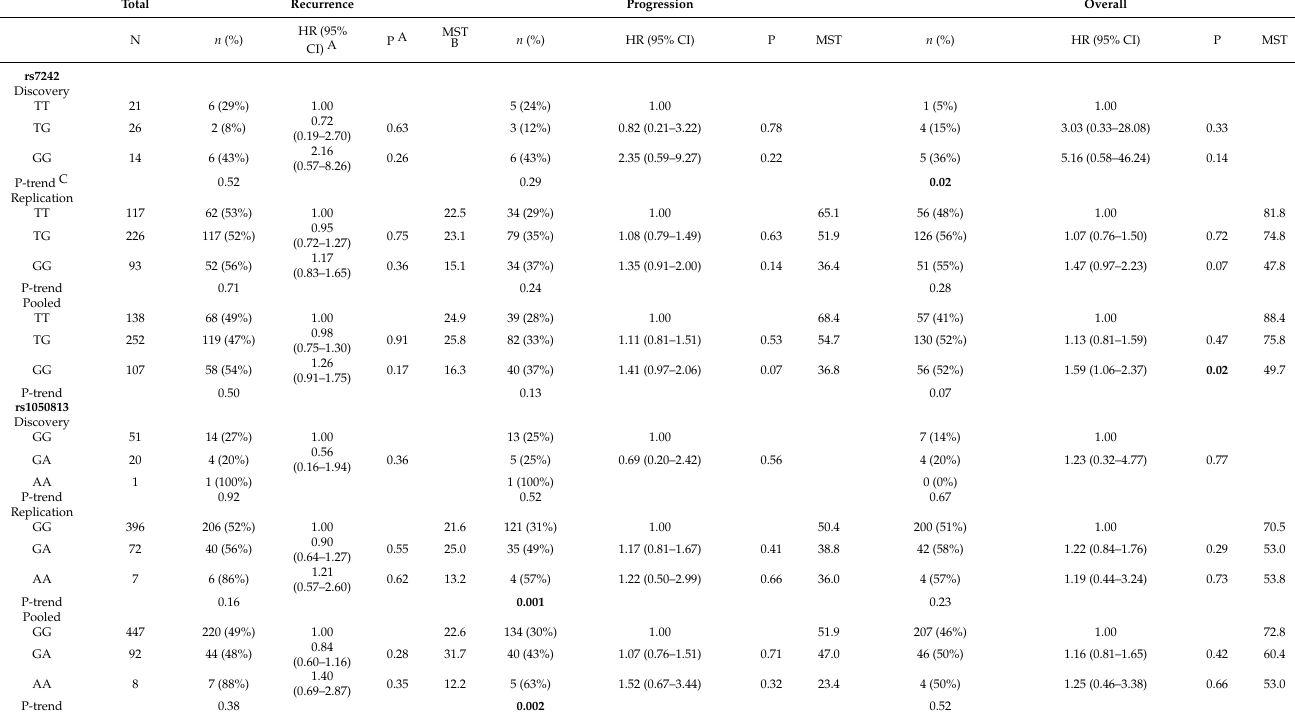
Table 2. Frequencies of common genetic alterations found in PAI-1